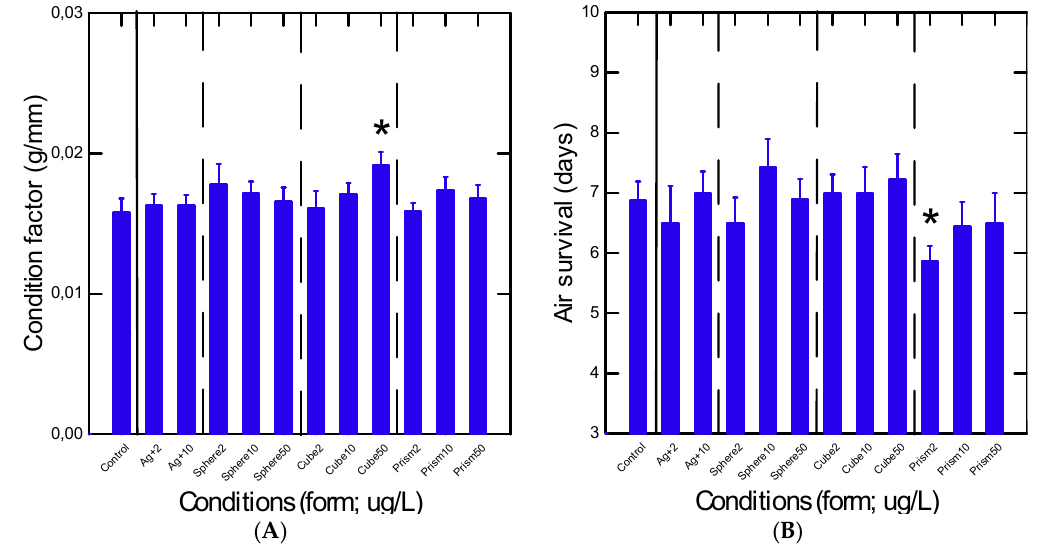
Figure 1. Condition factor and air survival time of mussels exposed to nAg geometries. Mussels were collected for condition factor ( A ) and air survival time ( B ). The data represent the mean with the standard error. The star symbol * indicates significant differences from